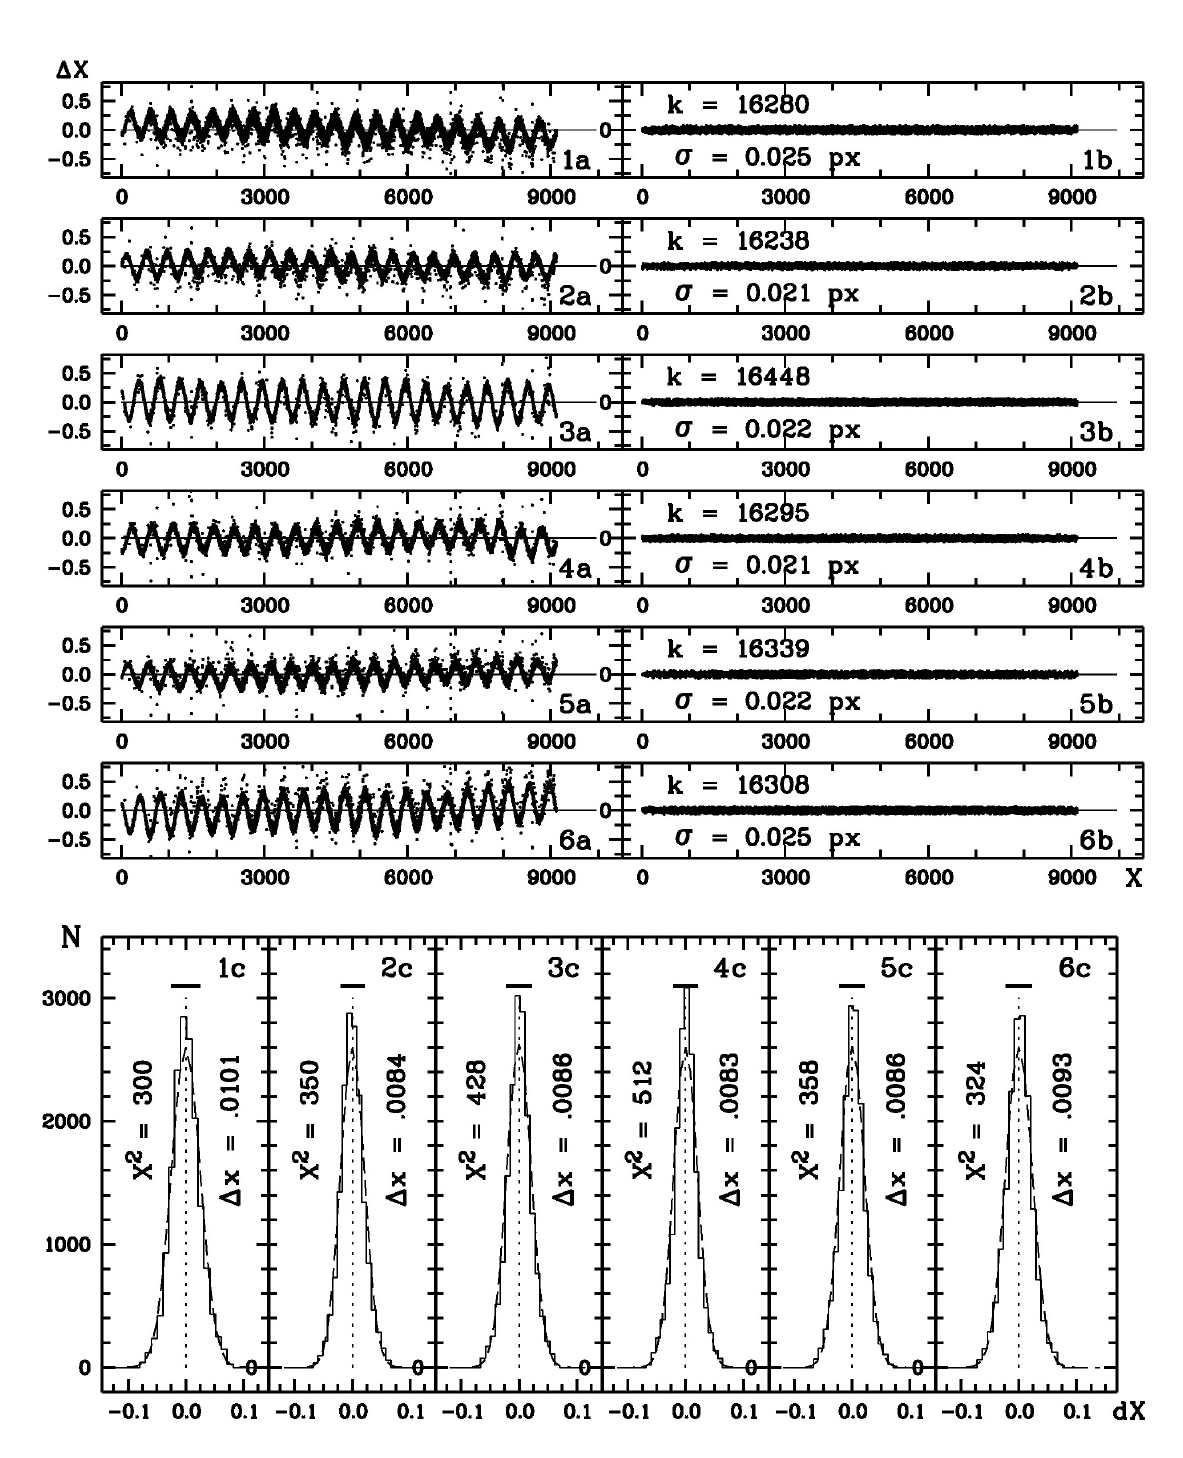
Figure 5a. The differences for the six consecutive scans relatively to the average scan for coordinate X. On the bottom the frequency dis- tribution of the differences. The values are given in the form of real (solid lines) and theoretical (dash lines) distribution functions for the respective intervals. The value of interval length ∆x and the value X 2 (on the right and the left respectively) are